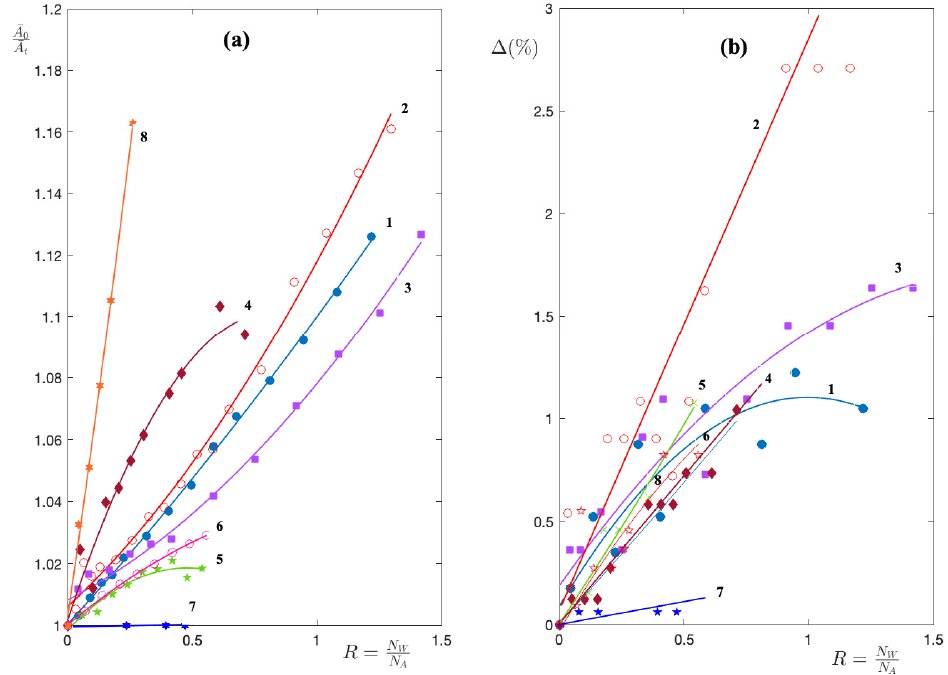
Figure 5. ( a ) Normalized integral absorbance as a function of the hydrophilicity index, in ternary systems NR–H–(CH 2 ) n –OH–water (the n value is read directly on each line). ( b ) Average percentage increase of NR red shift in ternary systems NR–H–(CH 2 ) n –OH–water (the n value is read directly on each line).